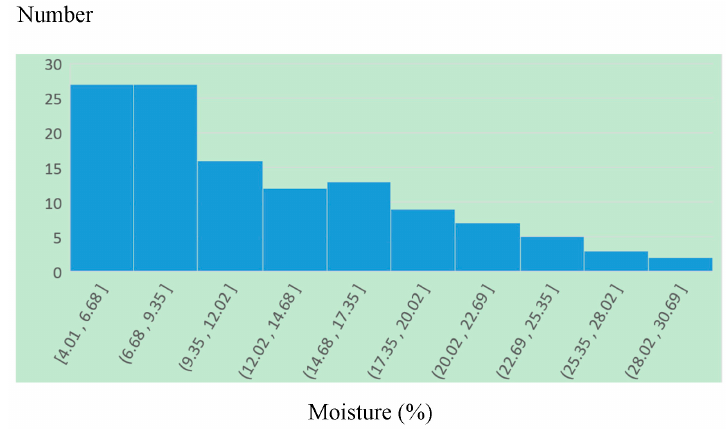
Figure 9. Histogram of fine sediment moisture.